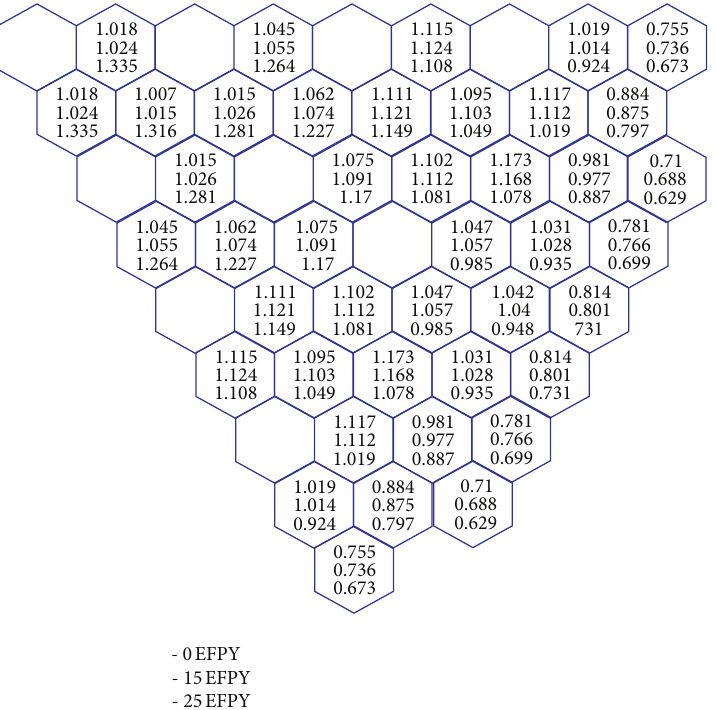
Figure 14: Assembly-wise power distribution at 0EFPY/15EFPY/25EFPY.